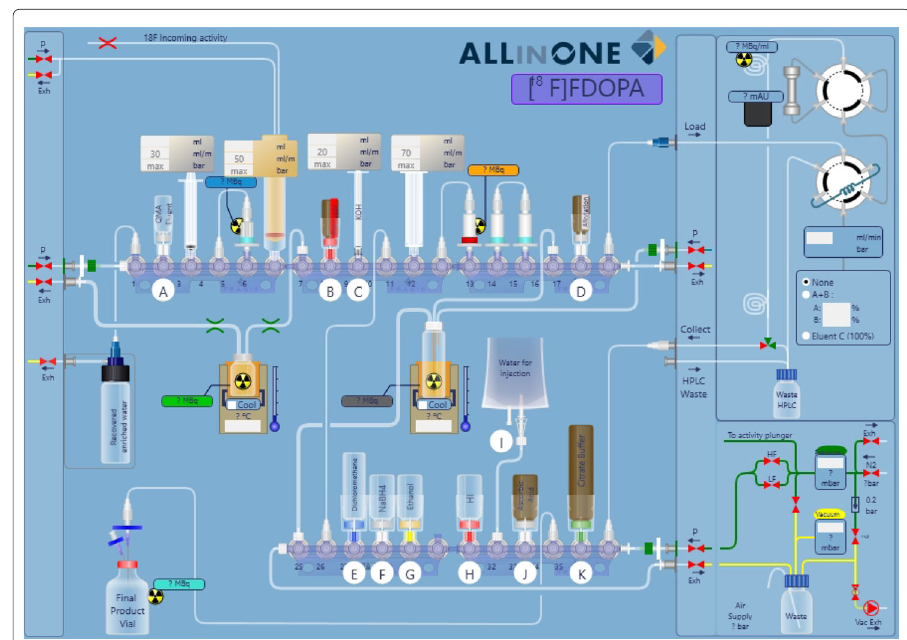
Trasis AIO module by